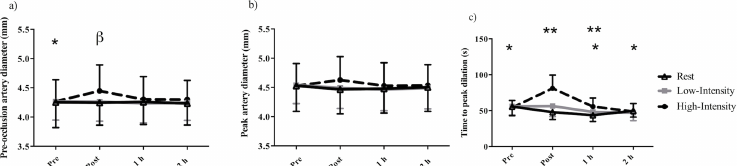
Fig 1. Mean (a) pre-occlusion artery diameter, (b) peak artery diameter, (c) time to peak dilation in 17 recreationally active males prior to and following rest, low-intensity, or high-intensity cycling. Error bars represent SD. (cid:3) = significantly less than post for high-intensity only. (cid:3)(cid:3) = significant difference between high-intensity compared to low- intensity and rest at the same time point. β = significant difference between high-intensity compared rest at the same time